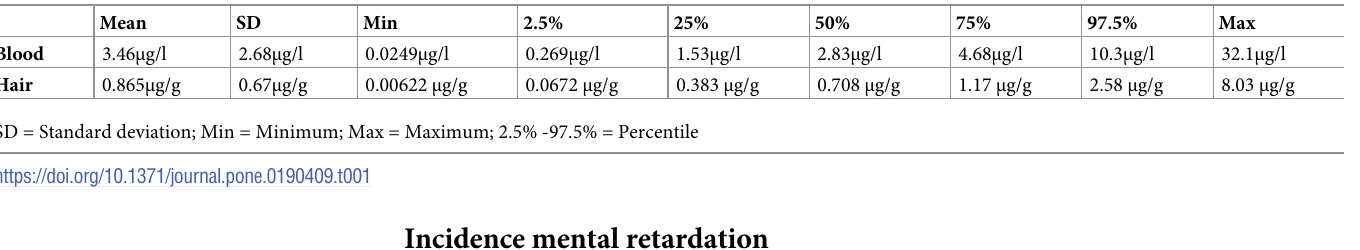
Distribution parameters of simulated maternal hair and blood methylmercury concentrations are shown in Table 1.